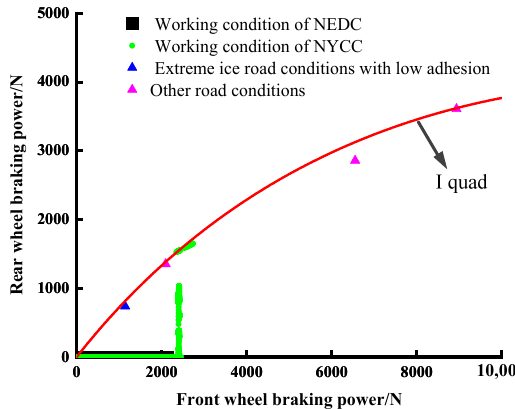
Figure 11. The distribution situation of braking force distribution.